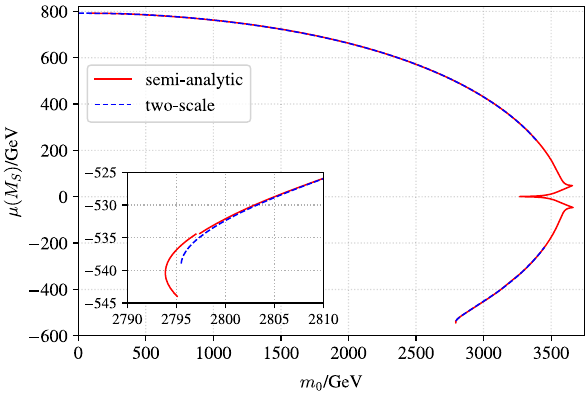
Fig. 3 MultiplesolutionsintheCMSSM,foundwiththesemi-analytic solver for the low-energy input parameters { M Z , G F } and the CMSSM parameters given in Eq.(9). The results from the two-scale solver are shown for